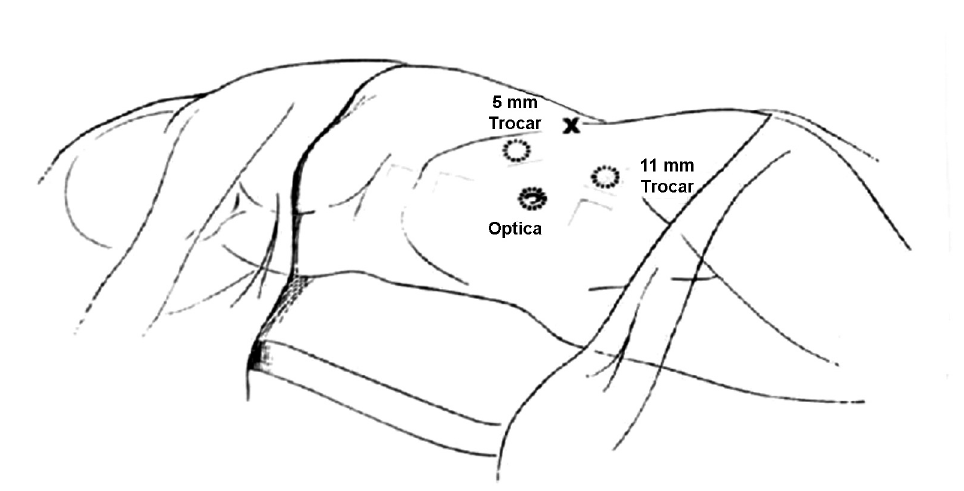
Figure 1 – Patient position for the